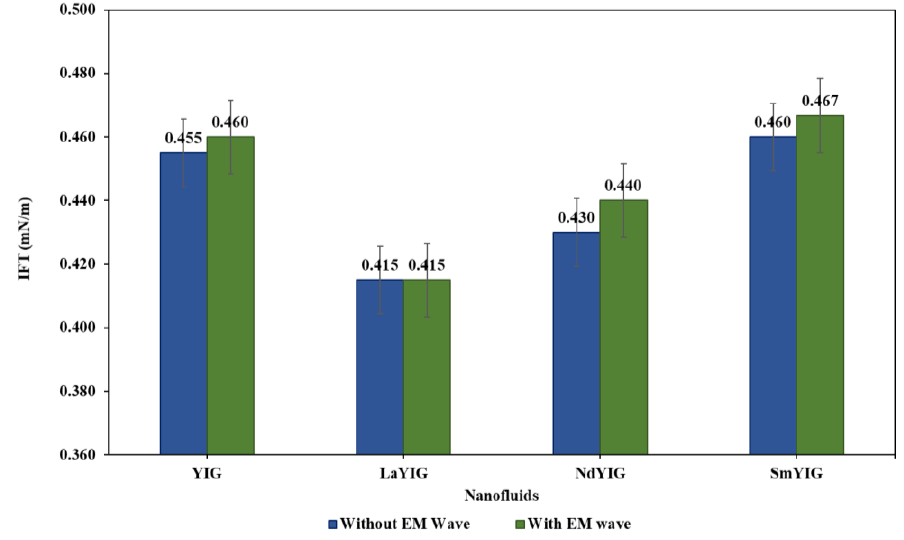
Figure 6. Interfacial tension (IFT) for RE-YIG samples with and without EM waves.